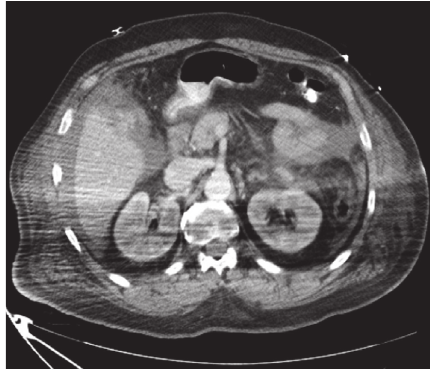
Figure 2: CT scan of abdomen and pelvic showing hemoperitone- um and mass-like density abutting gallbladder.